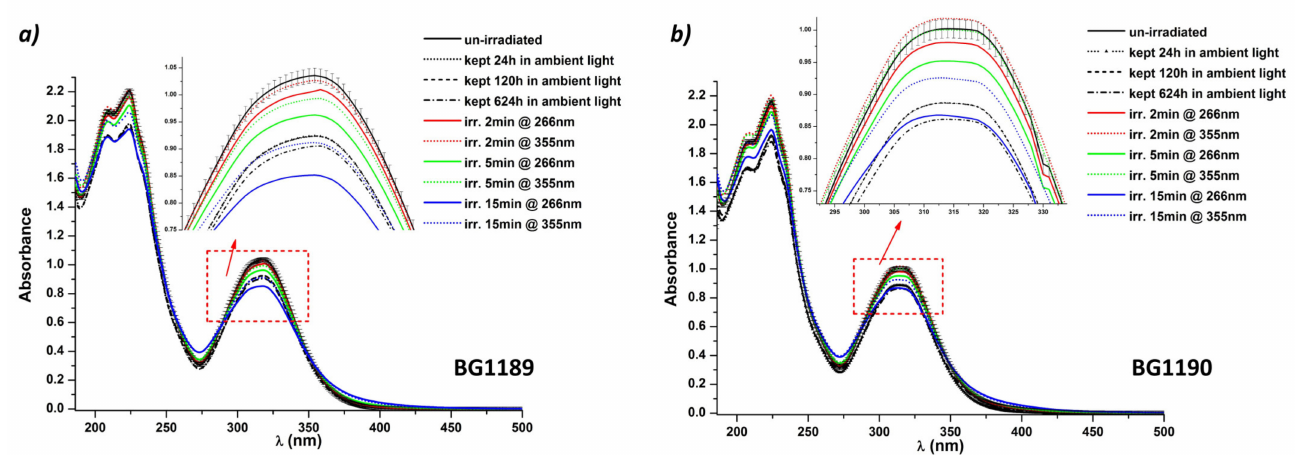
Figure 5. Influence of the illumination conditions on the absorption spectra of: ( a ) BG1189 and ( b ) BG1190. Solutions prepared in ultrapure water at 10 − 3 M, kept at 22 ◦